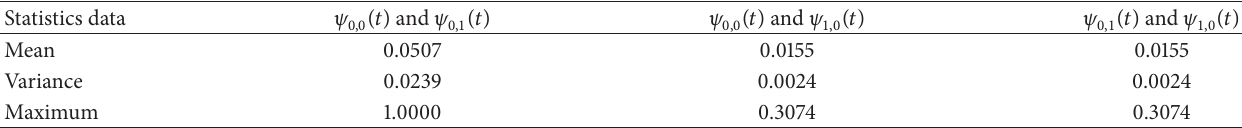
Table 4: Statistics of asynchronous mutual correlation values for coif5